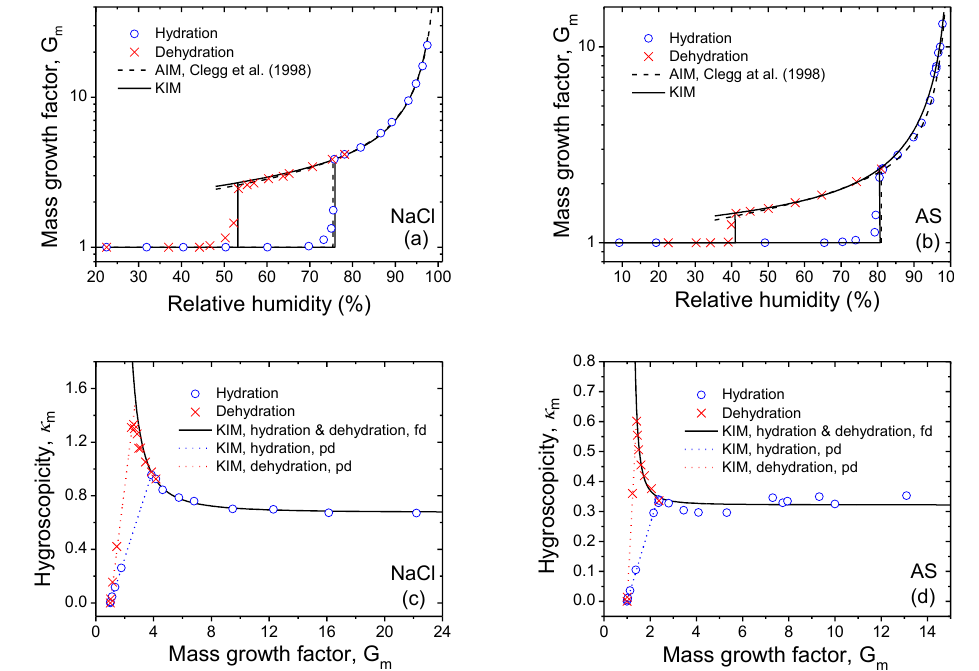
Figure 2: Hygroscopic properties of sodium chloride (NaCl ) and ammonium sulfate (AS ) particles: (a, b) mass growth factors ( G m ) observed as a function of relative humidity; (c, d) mass-based hygroscopicity parameters ( κ m ) calculated as a function of mass growth factor (Appendix C, Eq. C2). The data points are from FDHA experiments of hydration (blue circles) and dehydration (red crosses). The lines represent different models: (a, b) KIM – black solid; AIM reference – black dashed; (c, d) KIM for fully dissolved (fd) particles (Eq.29) – black solid; KIM for partly dissolved (pd) particles (Eq. 28) – blue dotted upon hydration and red dotted upon dehydration.